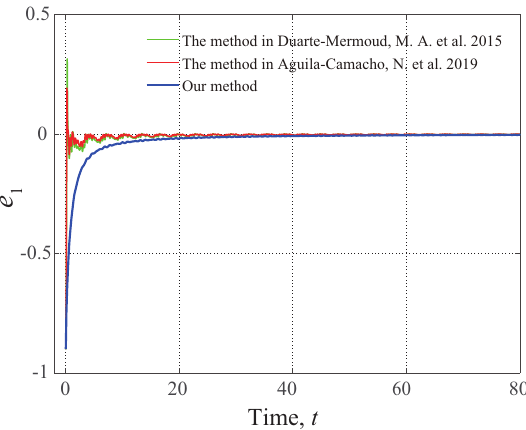
Figure 9. Time evolution of tracking error e 1 ( t ) with the standard fractional order adaptive con- troller in Duarte-Mermoud, M. A. et al. [23], the fractional adaptive controller in Aguila-Camacho, N. et al. [24], and our proposed adaptive controller with the fractional-order scalar update law in this paper.